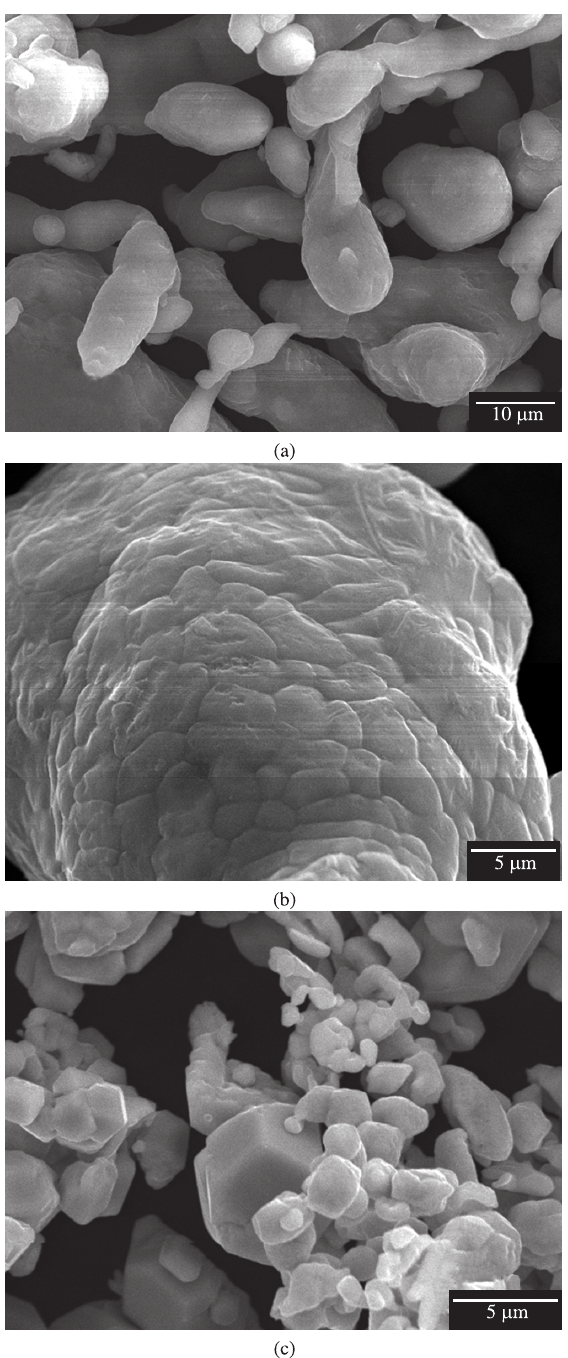
Figure 1. Raw material: a, b) Al-powder; and c)